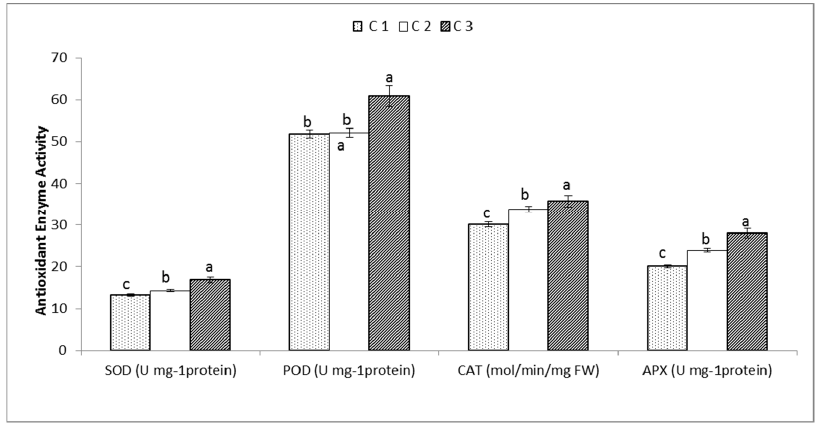
Figure 3. Phytochemical parameters for the studied C. gileadensis accessions (C1: collected from Jed- dah, C2: collected from Jizan and C3: collected from Riyadh); TPC: total phenolic content; TFC: total flavonoids content. Bars with different letters indicate significant differences between treatments at p ≤ 0.05. Data are expressed as the mean of three replicates ± SDs.